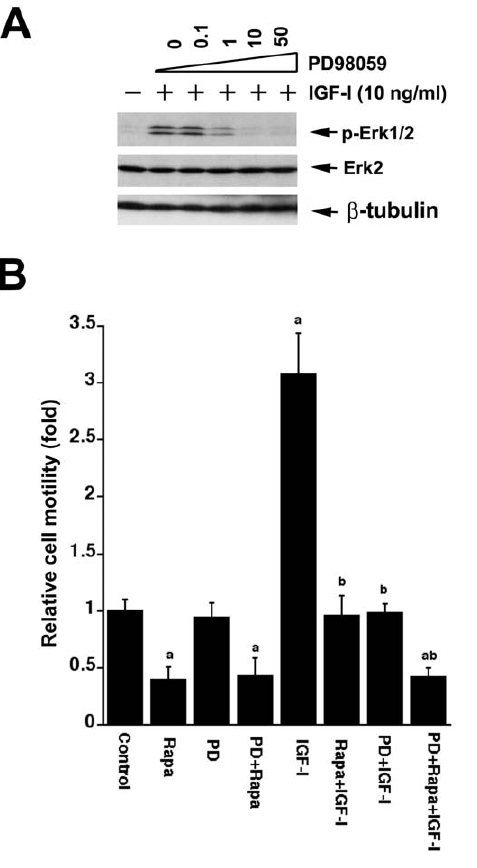
Figure 5. Inhibition of Erk1/2 with PD98059 blocks IGF-1- stimulated cell motility. (A) Serum-starved Rh1 cells were exposed to increasing concentrations of PD98059 (0–50 m M) for 2 h, and then to IGF-1 for 15 min, followed by Western blotting using the indicated antibodies. (B) Motility of Rh1 cells was determined by the wound healing assay. Serum-starved cells were pretreated for 2 h with rapamycin (Rapa) (100 ng/ml) or PD98059 (PD) (10 m M) alone, or in combination as indicated, followed by stimulation with or without IGF-1 (10 ng/ml) for 22 h. Results are means 6 SE of 3–4 independent experiments. a P , 0.05, difference vs. control group; b P , 0.05, difference vs. IGF-1 group.